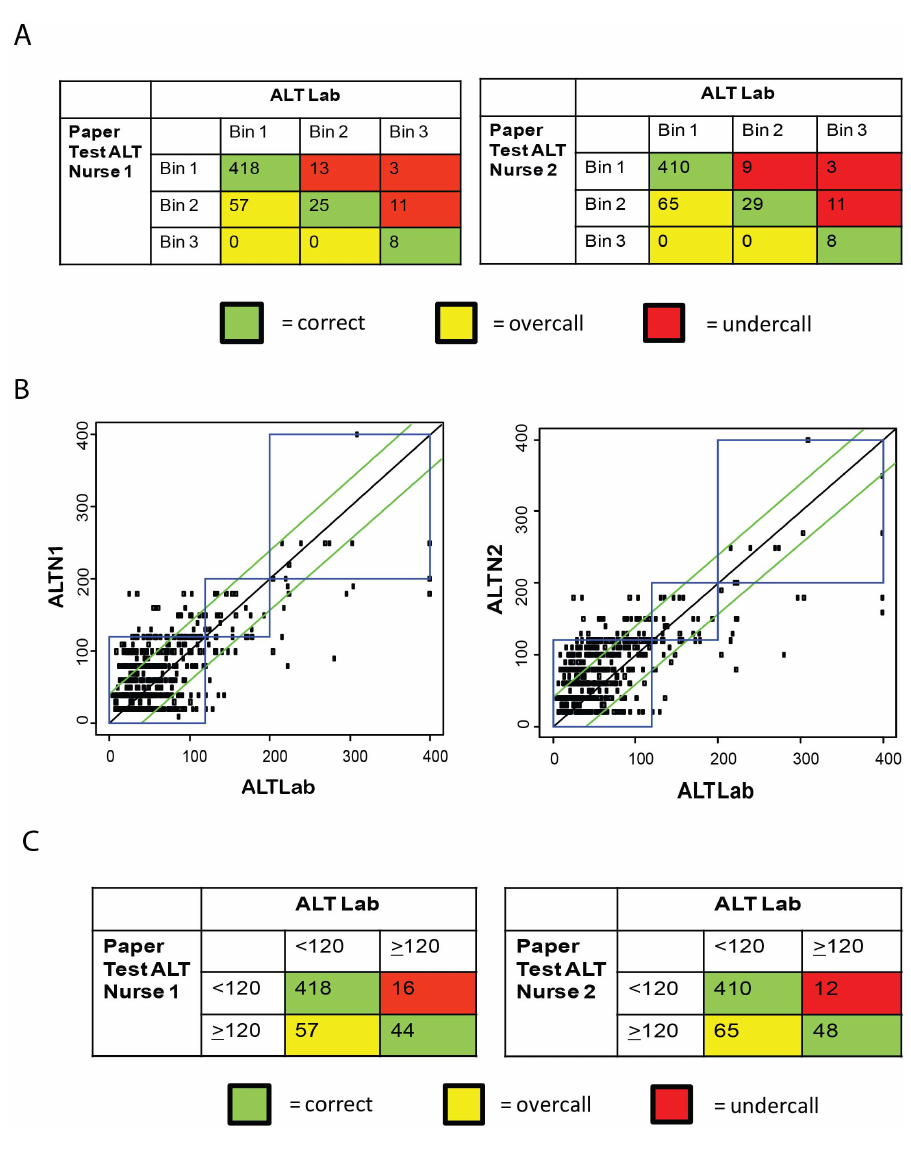
Figure 2. Comparison of paper-based transaminase test results to automated test results. (A) Bin placement accuracy. Nurse 1 (left table) and Nurse 2 (right table) visual device results (classified by ‘‘bin,’’ i.e. Bin 1= , 3x ULN [0–119 U/L], Bin 2=3–5x ULN [120–200 U/L], and Bin 3= . 5x ULN [ . 200 U/L]) were compared with automated device results (ALT Lab, also classified by bin) as the gold standard. Colored boxes indicate result pairs in which the visual result was in the same bin as the automated result (green, ‘‘correct’’), a higher bin than the automated result (yellow, ‘‘overcall’’), or a lower bin than the automated result (red, ‘‘undercall’’). Per-bin accuracy for visual reading (Results) was calculated by dividing the number of correctly binned samples in each bin by the total number of samples in that bin. Overall bin placement accuracy (Results) was defined as the overall percentage of visual device results which fell in the same bin as the paired automated result. (B) Direct comparison of Nurse 1 (left plot, ALTN1) and Nurse 2 (right plot, ALTN2) visual device results to automated test results (ALTLab) for each subject. In each plot, the black diagonal line corresponds to the line of equality; the green diagonal lines correspond to + / 2 40 U/L from the line of equality; and the blue boxes represent ALT bins within which values for both the paper-based device and the automated method are within the same range: , 3x ULN (0–119 U/L), 3 to 5x ULN (120–200 U/L), or . 5x ULN ( . 200 U/L). (C) Reanalysis of the bin placement results (Nurse 1, left table; Nurse 2, right table) using a binary cutoff creating only two bins ( , 120 U/L=low, $ 120 U/L=high), as might be used in a ‘‘triage’’ or ‘‘screening’’ use scenario. (ALT=alanine aminotransferase. ULN=upper limit of normal).